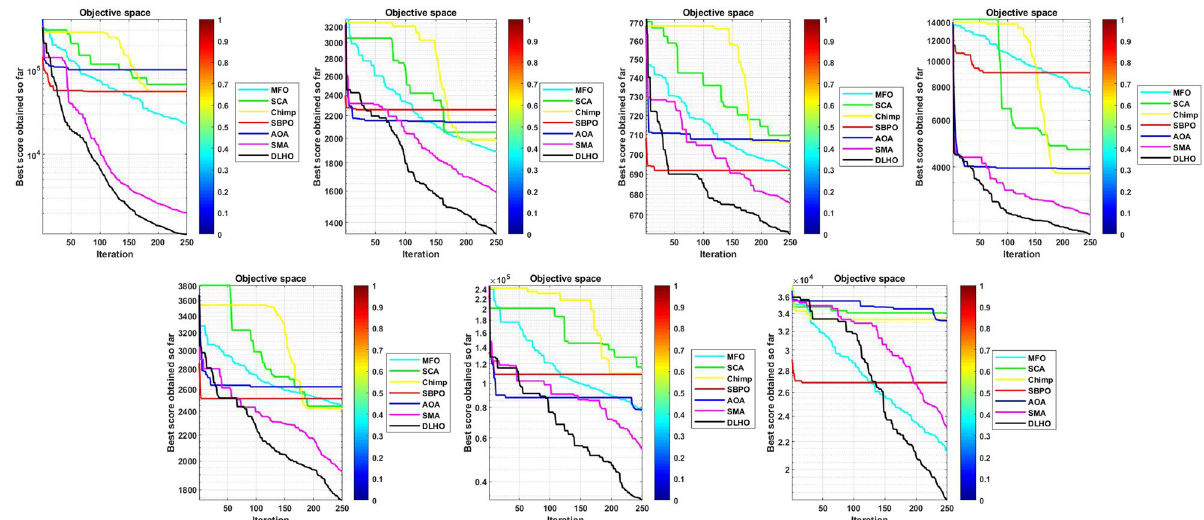
Figure 5. Performance graphs of Optimizers on simple-multimodal test suites.